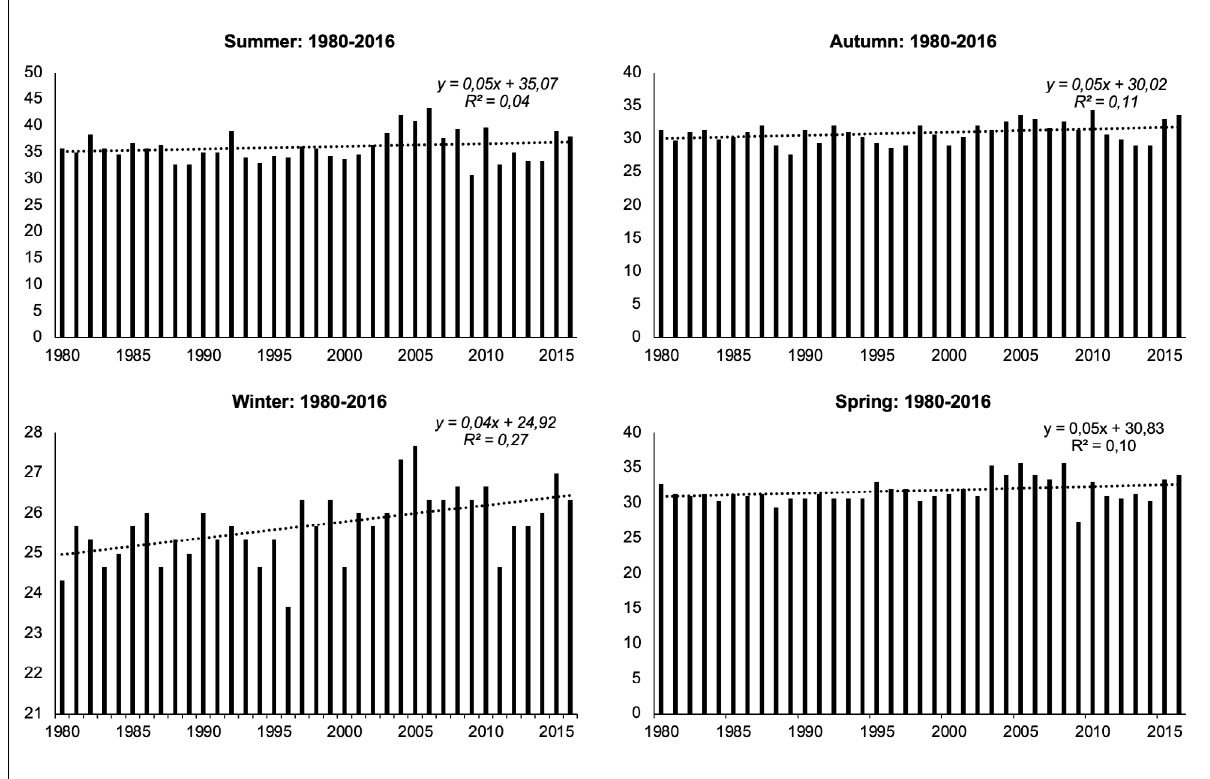
Figure 11: Seasonal heat index values based on maximum temperatures and relative humidity for the period 1980–2016 in northernmost Limpopo